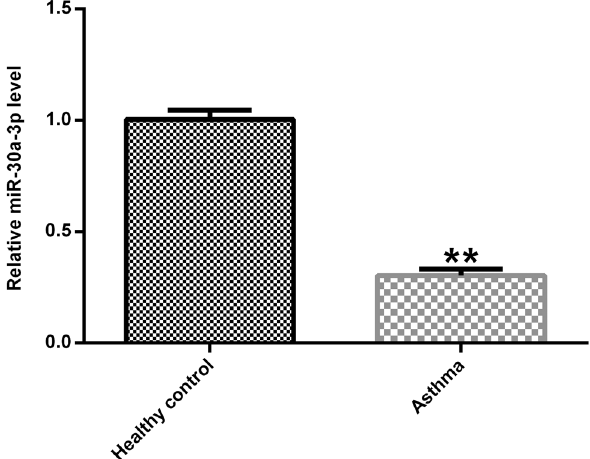
Figure 1: Expression of miR - 30a - 3p in asthmatic patients. The miR - 30a - 3p expression in asthmatic patients and healthy controls were determined using qRT -